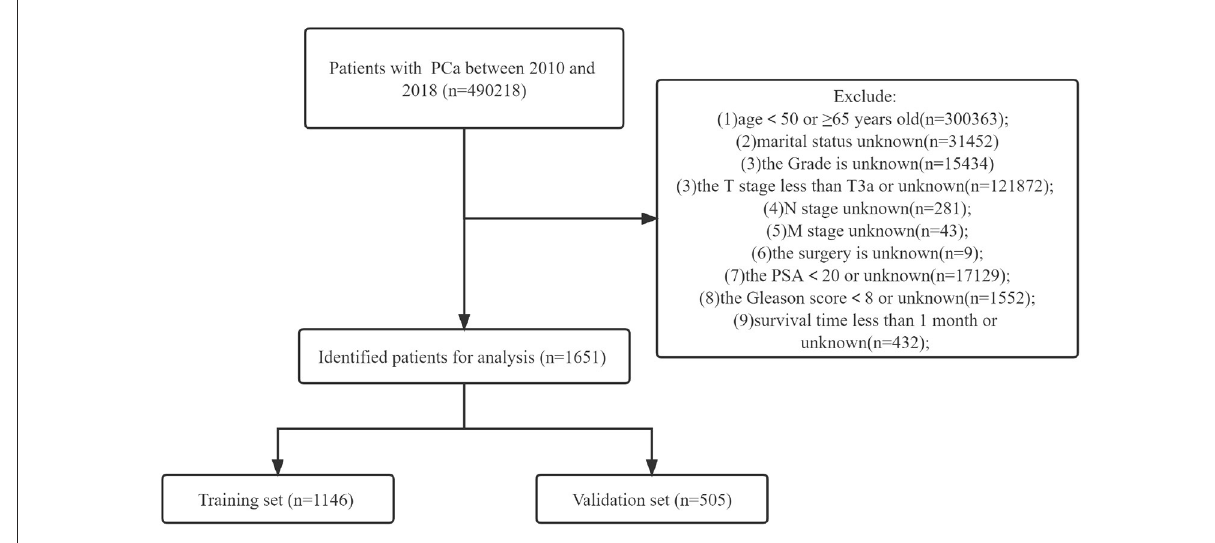
FIGURE1 Flowchart for inclusion and exclusion of middle aged high-risk prostate cancer.